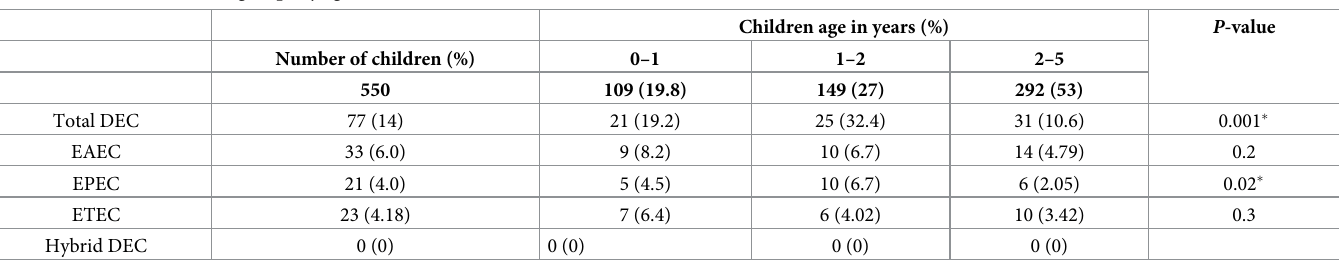
Table 4. Distribution of DEC groups by age in children without